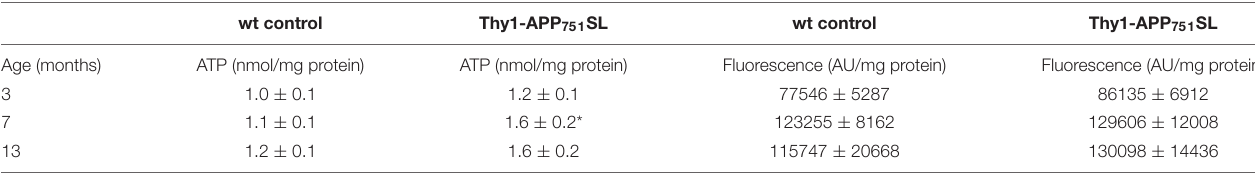
TABLE 3 | Relative normalized mRNA Expression of 3, 7, and 13 months old Thy1-APP 751 SL mice compared to wild-type mice of the same age.